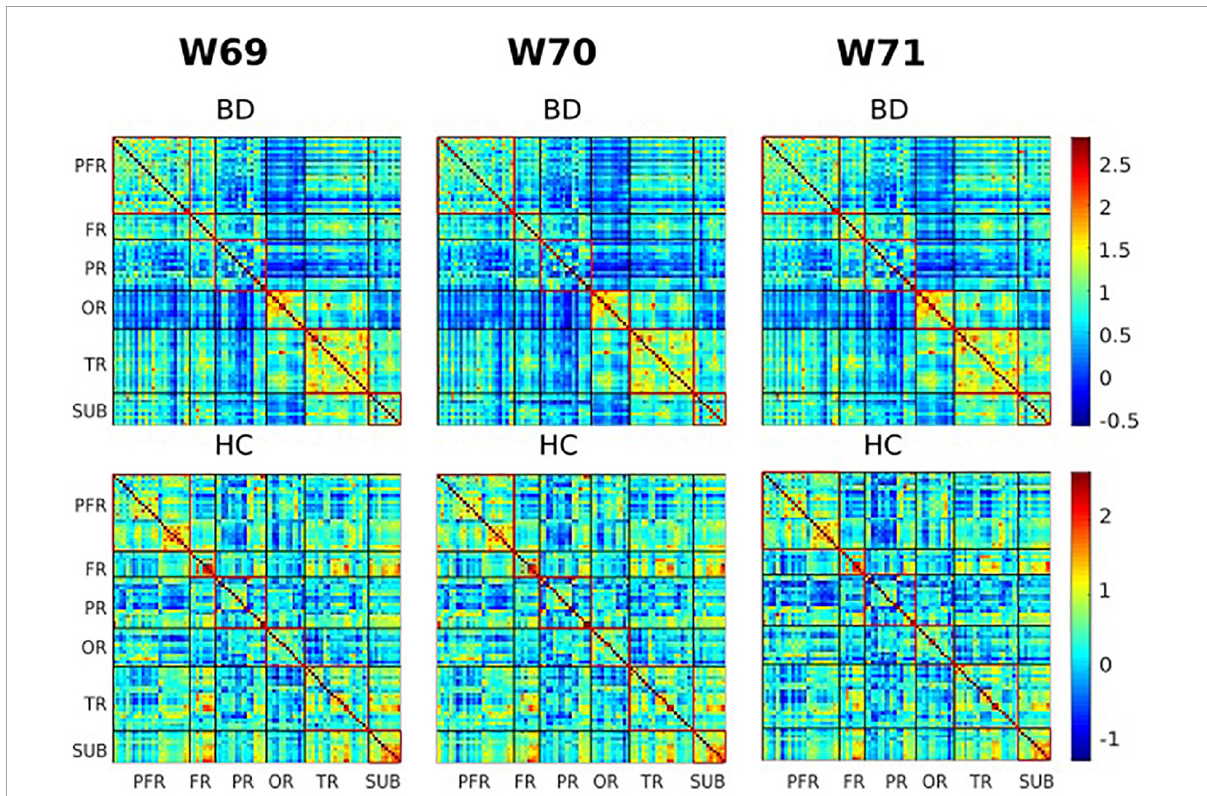
FIGURE4 Visualization of functional connectivity maps of one subject from the bipolar disorder (BD) and healthy controls (HC) group, respectively, at windows 69, 70, and 71 (180, 182, and 184 s). Values are plotted as –log10 ( p -value) × sign ( t -statistic). The lines partition the rsFC maps into six subcategories (i.e., PFR, prefrontal; FR, other frontal; PR, parietal; OR, occipital; TR, temporal; SUB, subcortical regions). The color bars represent correlation ( z